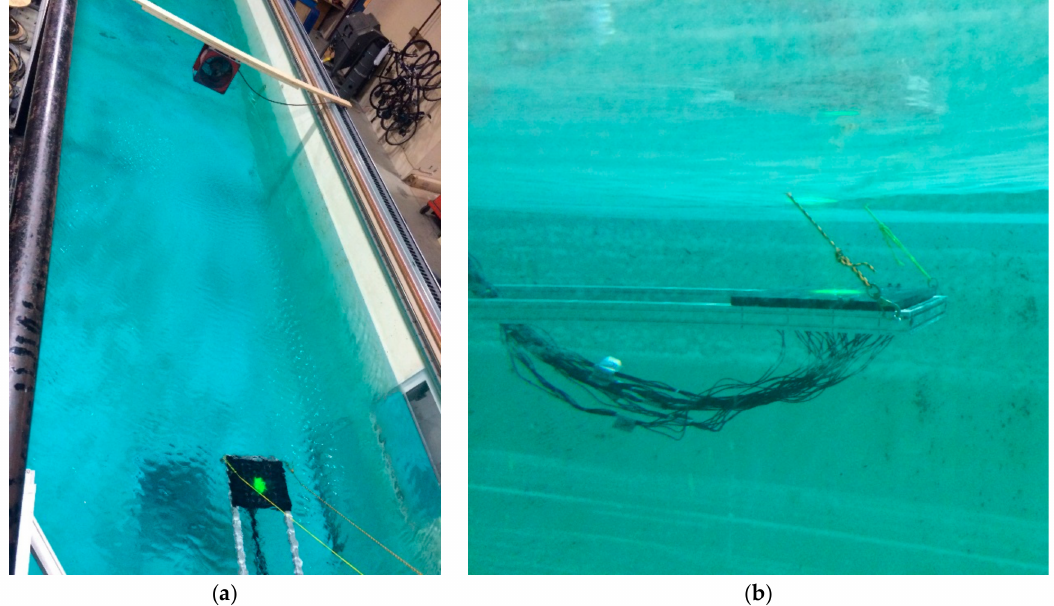
Figure 5. Experimental setup at the University of New Hampshire (UNH) Ocean Engineering laboratory. ( a ) The optical detector array and the industrial fan that creates a wind rippled water